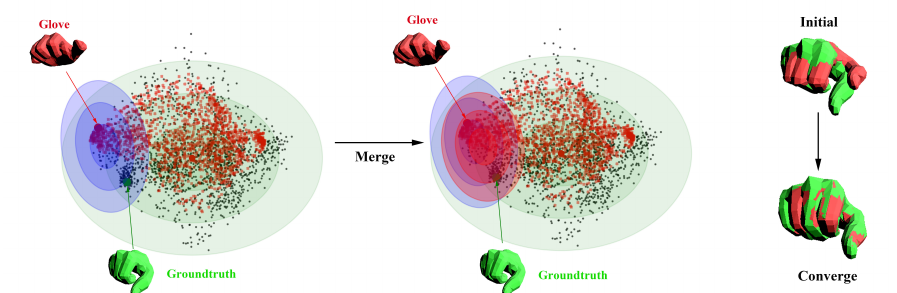
) and their fusion on a given Figure 12. An illustration of the influence of N ( 0, Σ ) and N ( µ dif f , Σ (cid:48) dif f glove input θ i . The red hand model is the initialization from our data glove, while the green one glove ) is convert to N ( ˜ θ i − is the ground-truth from the data-set [44]. The distribution of N ( µ dif f , Σ (cid:48) dif f glove ) with the specific input of glove θ i µ dif f , Σ (cid:48) . The red ellipse represents the distribution of dif f glove N ( µ merge , Σ merge ) , which shows a smaller search area and a closer µ merge toward the ground-truth. We also show the comparison between the initialization and convergence with the ground-truth on the right